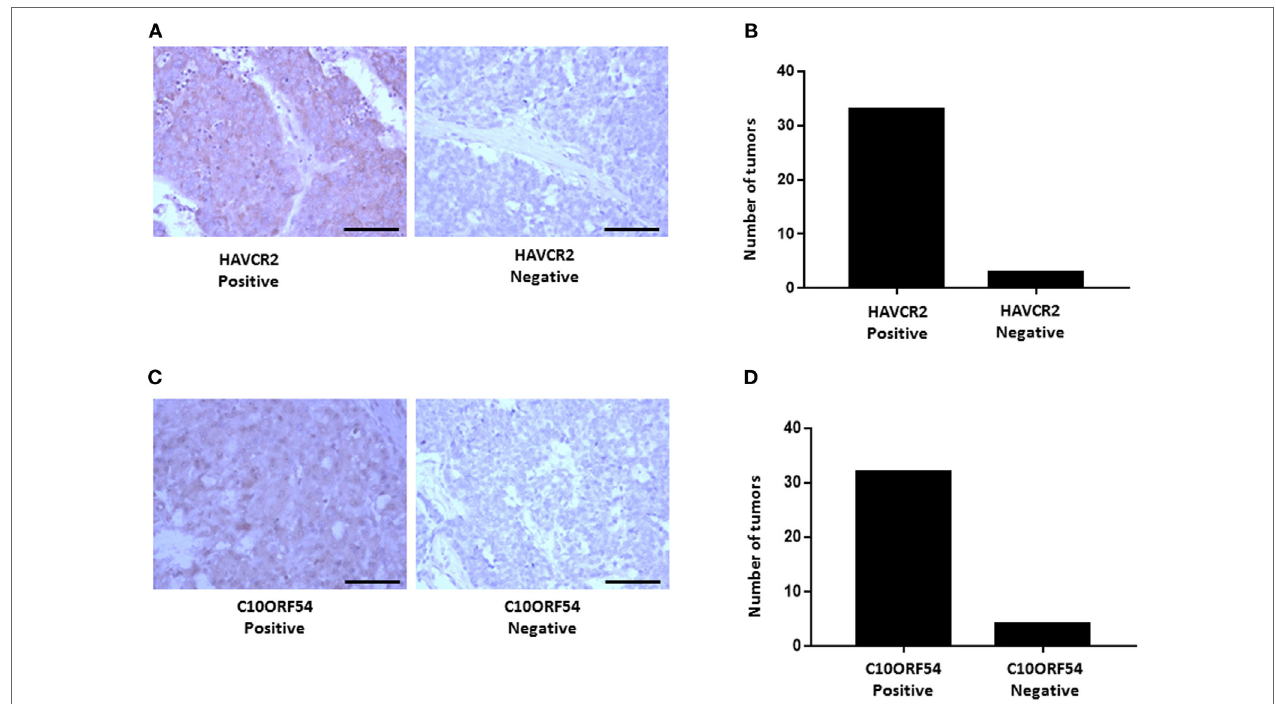
FigUre 11 | HAVCR2 and C10ORF54 immuno staining in HCC tumor tissue. (a) Localization of HAVCR2 in HCC tumor biopsies. (B) Graph represents number of tumors scored as HAVCR2 positive or negative. (c) Localization of C10ORF54 in HCC tumor biopsies. (D) Graph represents number of tumors scored as C10ORF54 positive or negative. Scale bar indicates 20 ×